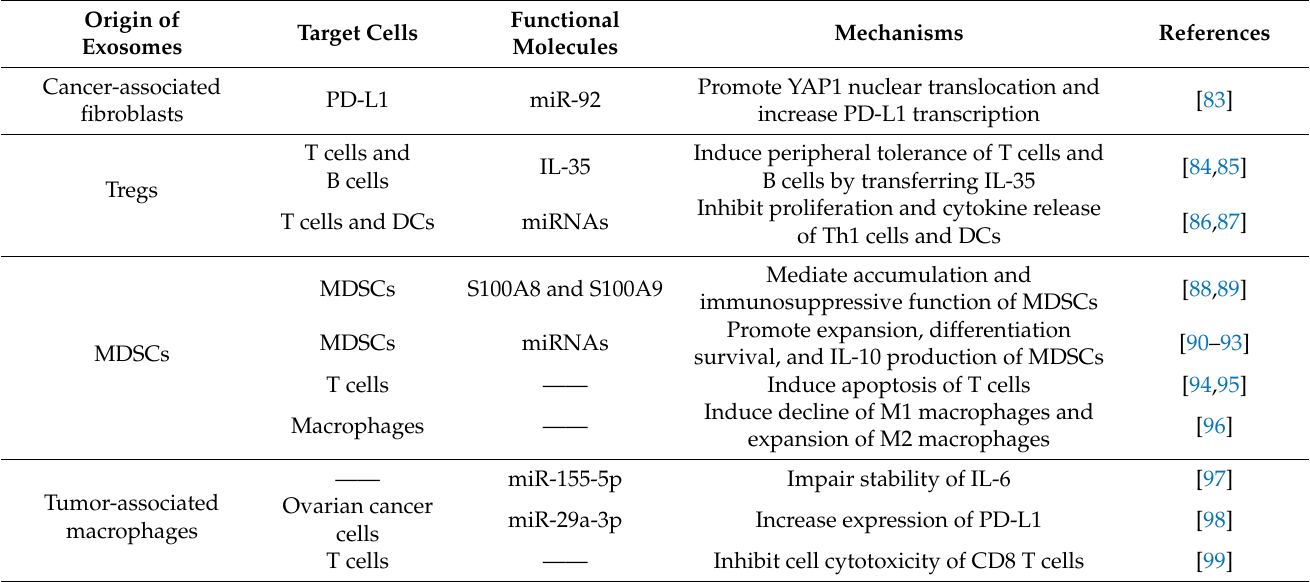
Table 2. Immunosuppressive effects of exosomes secreted by nontumor